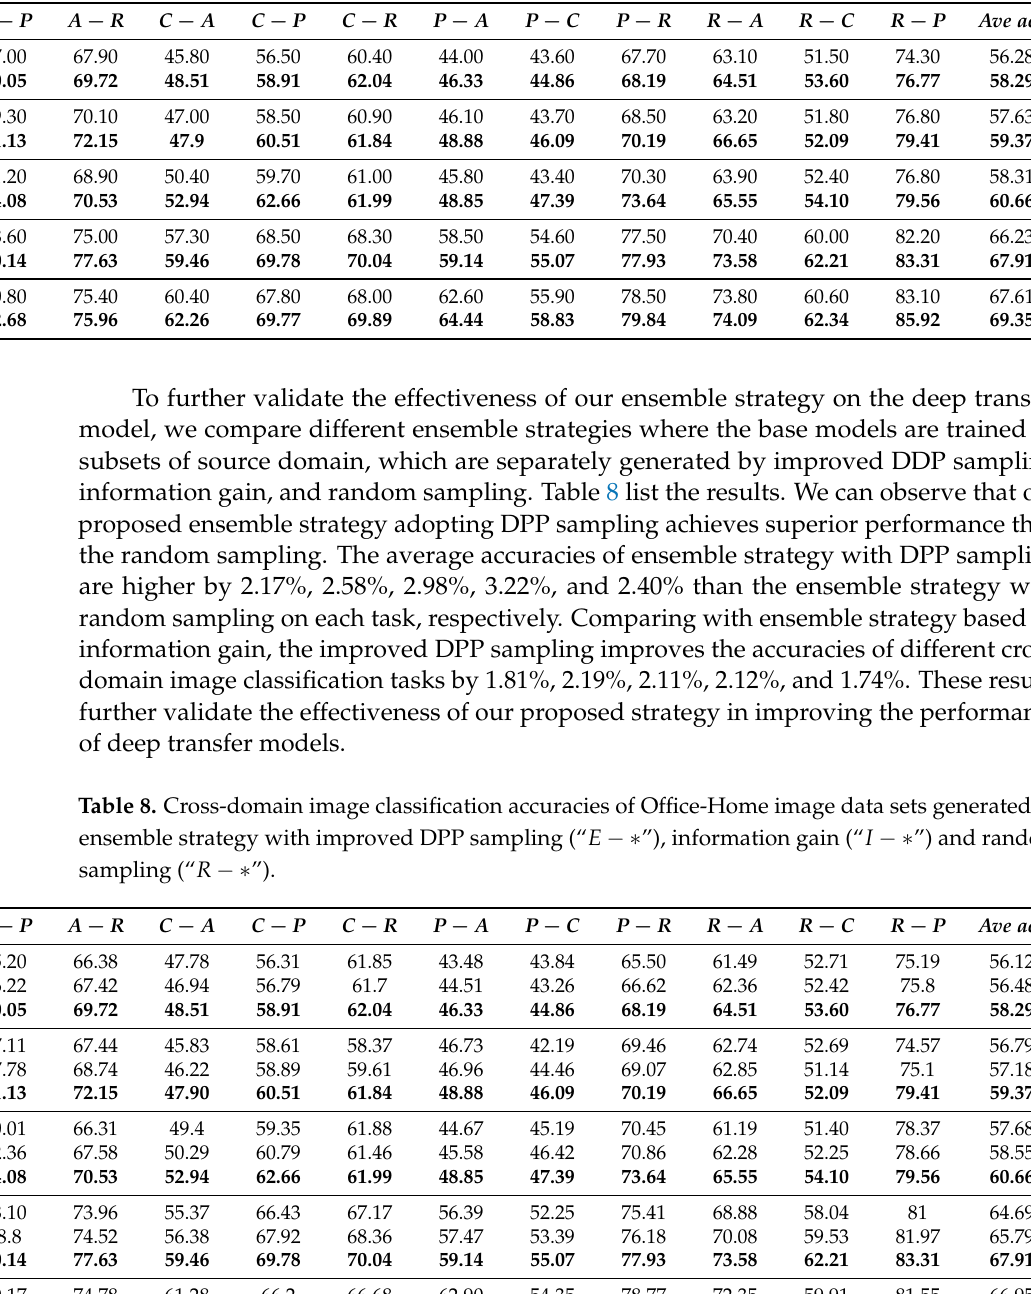
Table 7. Cross-domain classification accuracies of Office-Home image data sets generated by deep transfer methods with and without ensemble strategy.